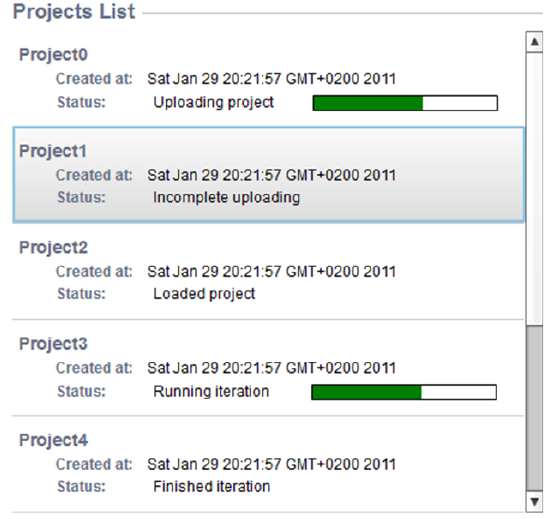
Fig. 5. User projects list.